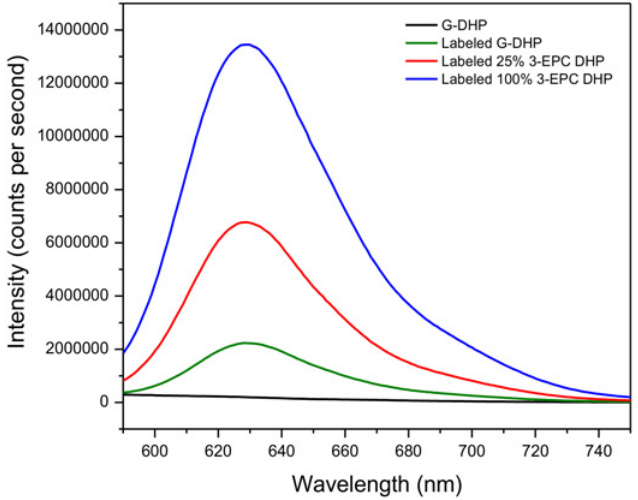
Fig 5. Fluorescence intensities (561 nm excitation) of click-labeled DHPs. 5 mg/ml solutions in DMSO of in vitro -synthesized DHPs incorporated with varying proportions of 3-EPC, 6 and click labeled with 1 μ M Alexa 594-azide for 1 h in the dark at room temperature. Blue trace: click labeled 100% 3-EPC DHP; red trace: click labeled 25% 3-EPC + 75% CA DHP; green trace: click labeled 100% CA DHP or G-DHP; black trace: non-labeled G-DHP. The red and blue spectra show significantly higher fluorescence intensities compared to labeled and non-labeled G-DHP. Detectable, but low, fluorescence in click labeled G-DHP is possibly due to physical entanglement of the dye with the